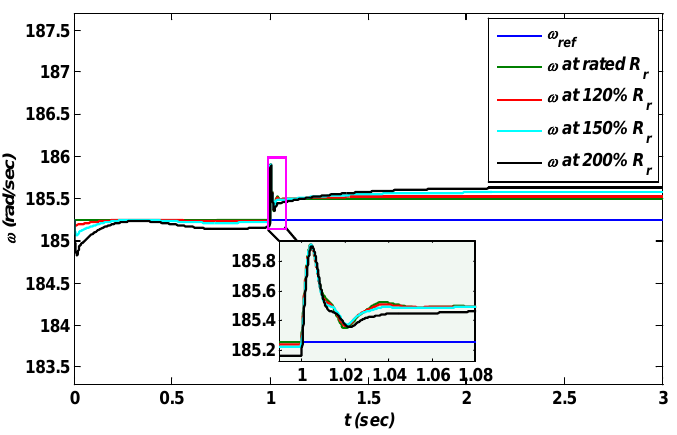
Figure 14. Speed control of IFOC IM using SD.